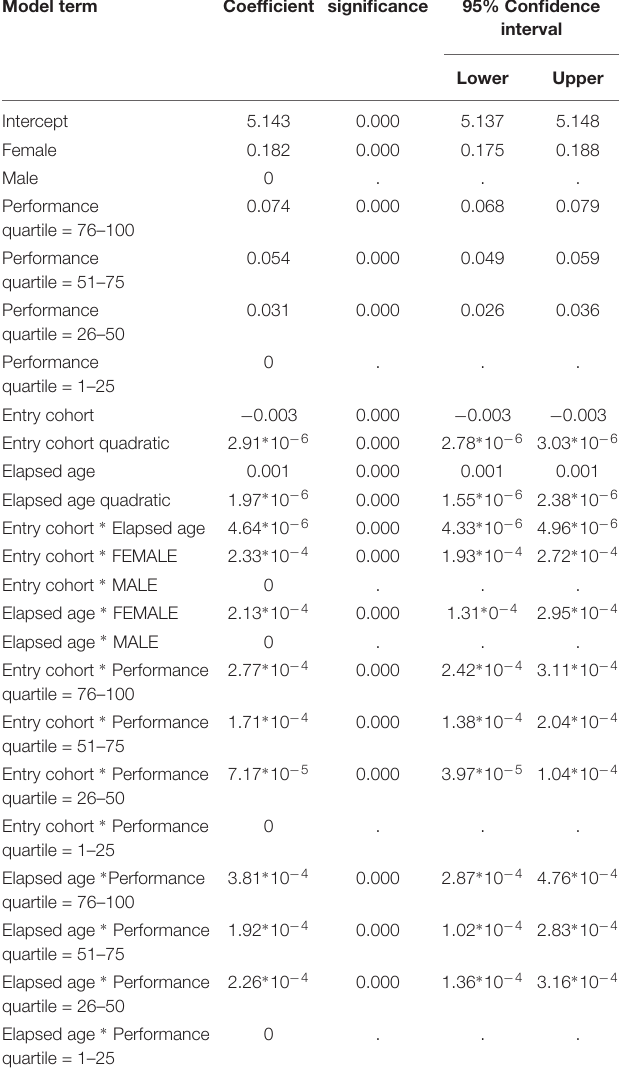
TABLE 3 | Fixed effect statistics for entry cohort model with performance time